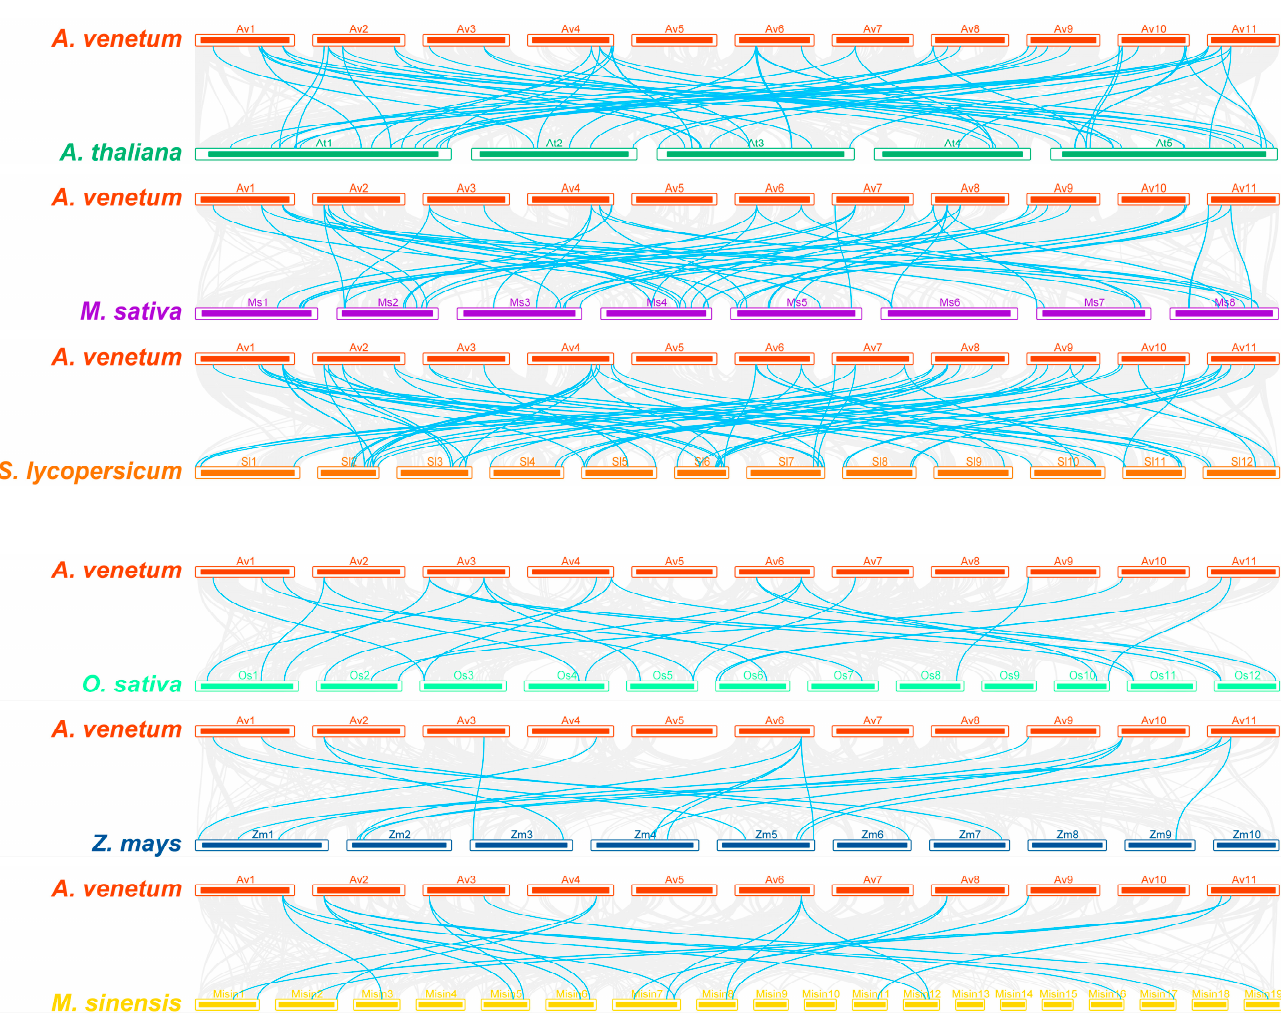
Figure 3. Synteny analysis of NAC genes between A. venetum and six other plant species ( A. thaliana , M. sativa , S. lycopersicum , O. sativa , Z. mays and M. sinensis ). The gray lines in the background represent collinear relationships between A. venetum and six other species, while the cyan lines highlight the syntenic NAC gene pairs.